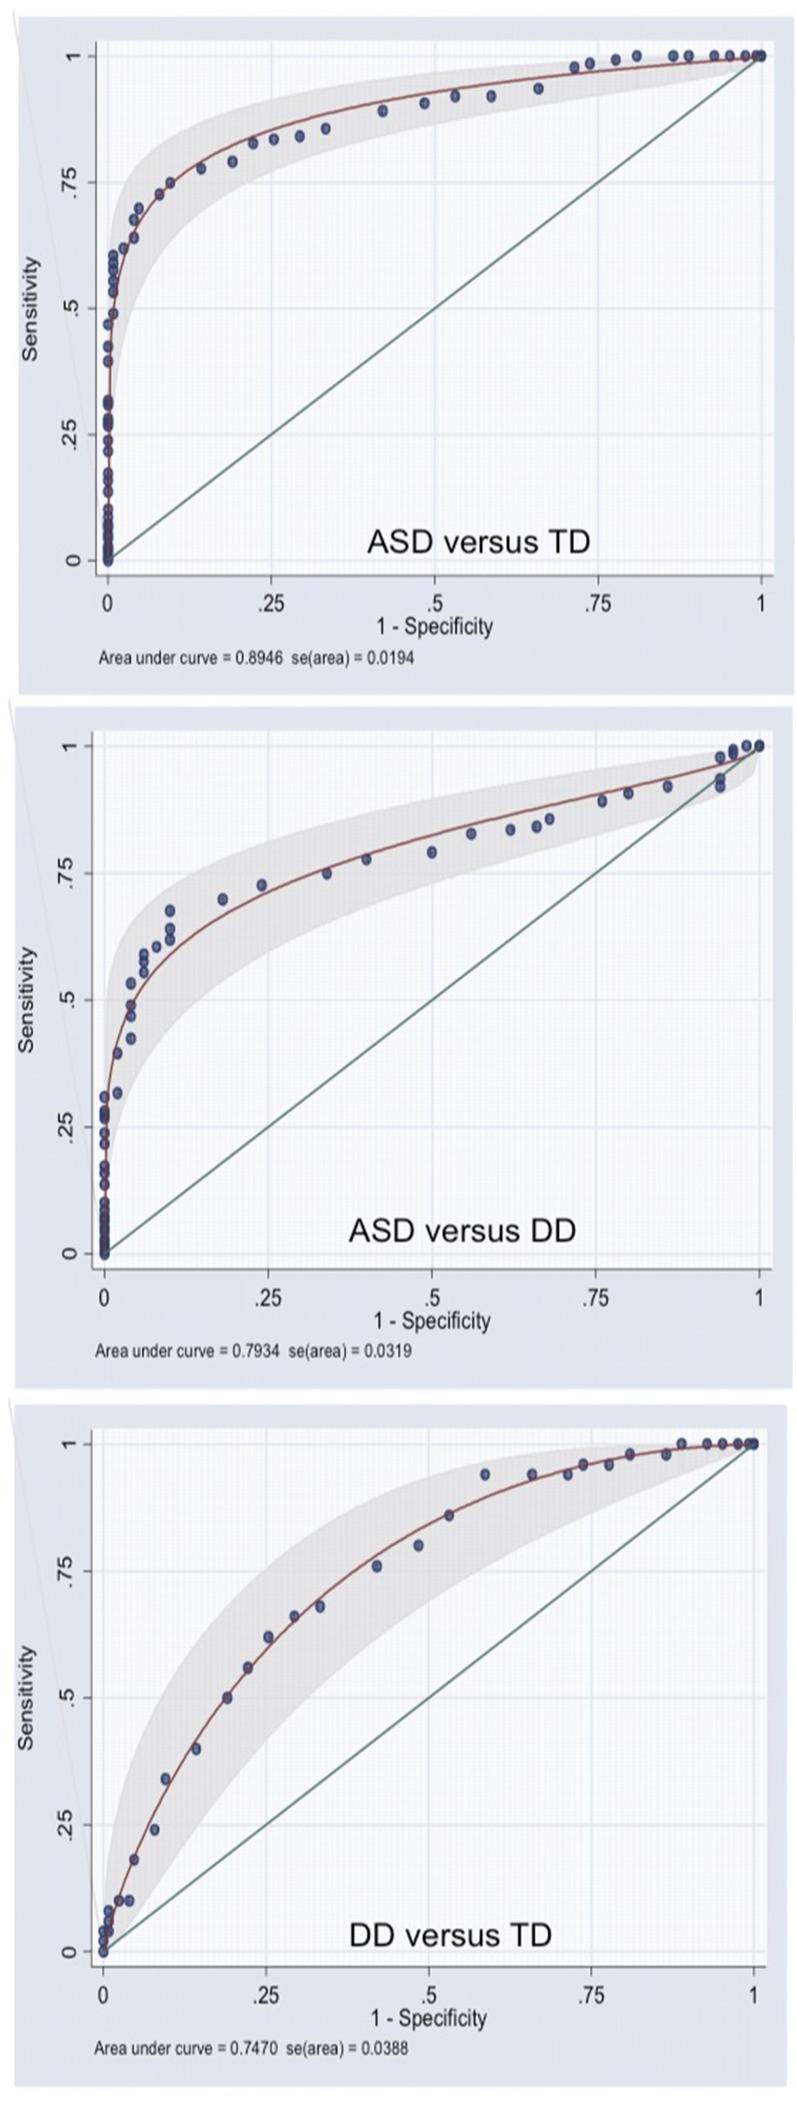
Area under the curve for the Q-CHAT.